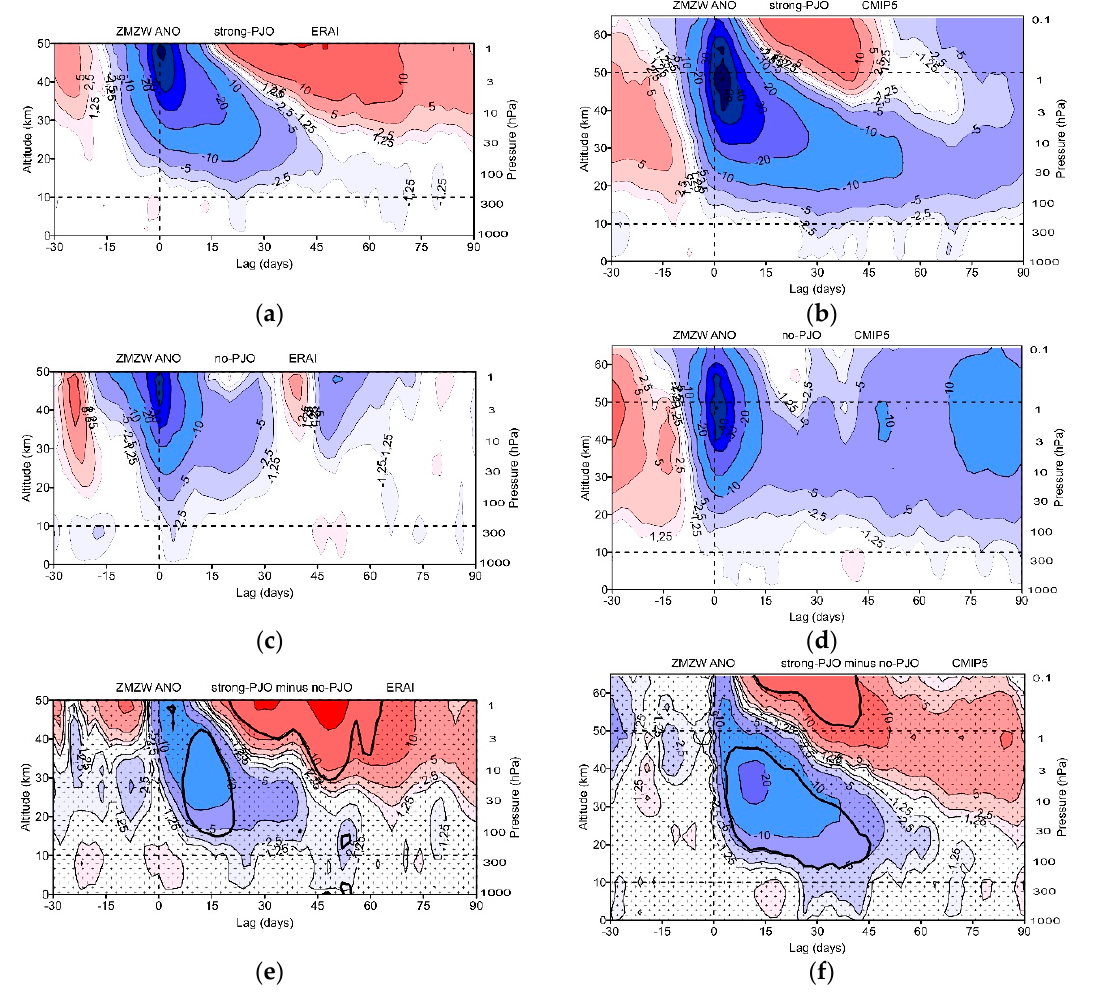
Figure 2. Same as Figure 1 but for the evolution of zonal mean zonal wind (ZMZW) anomaly (m/s) averaged between 50° and 70° N.